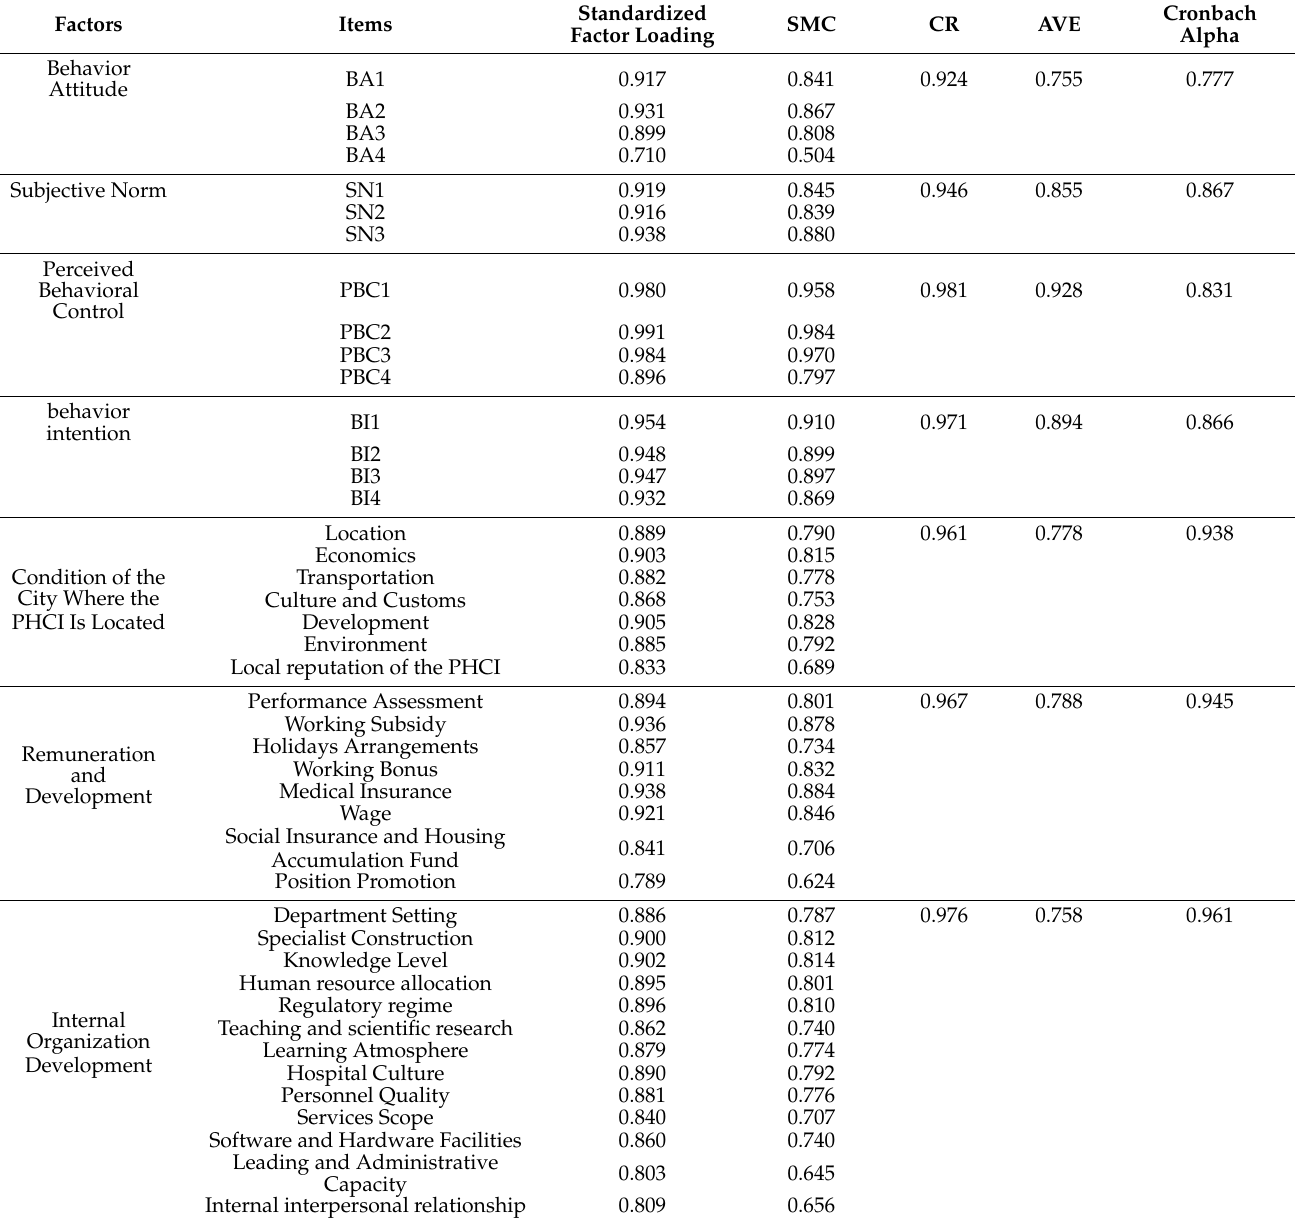
Table 3. Reliability and validity